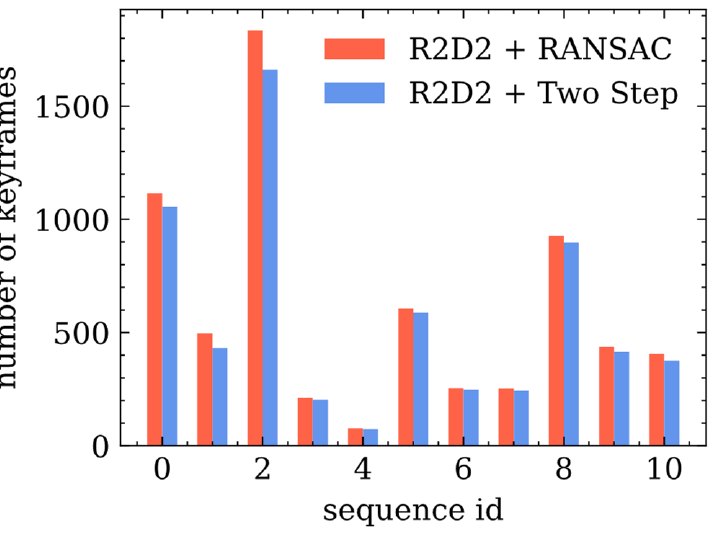
Figure 6. Number of keyframes inserted by RANSAC and two-step pose estimation.